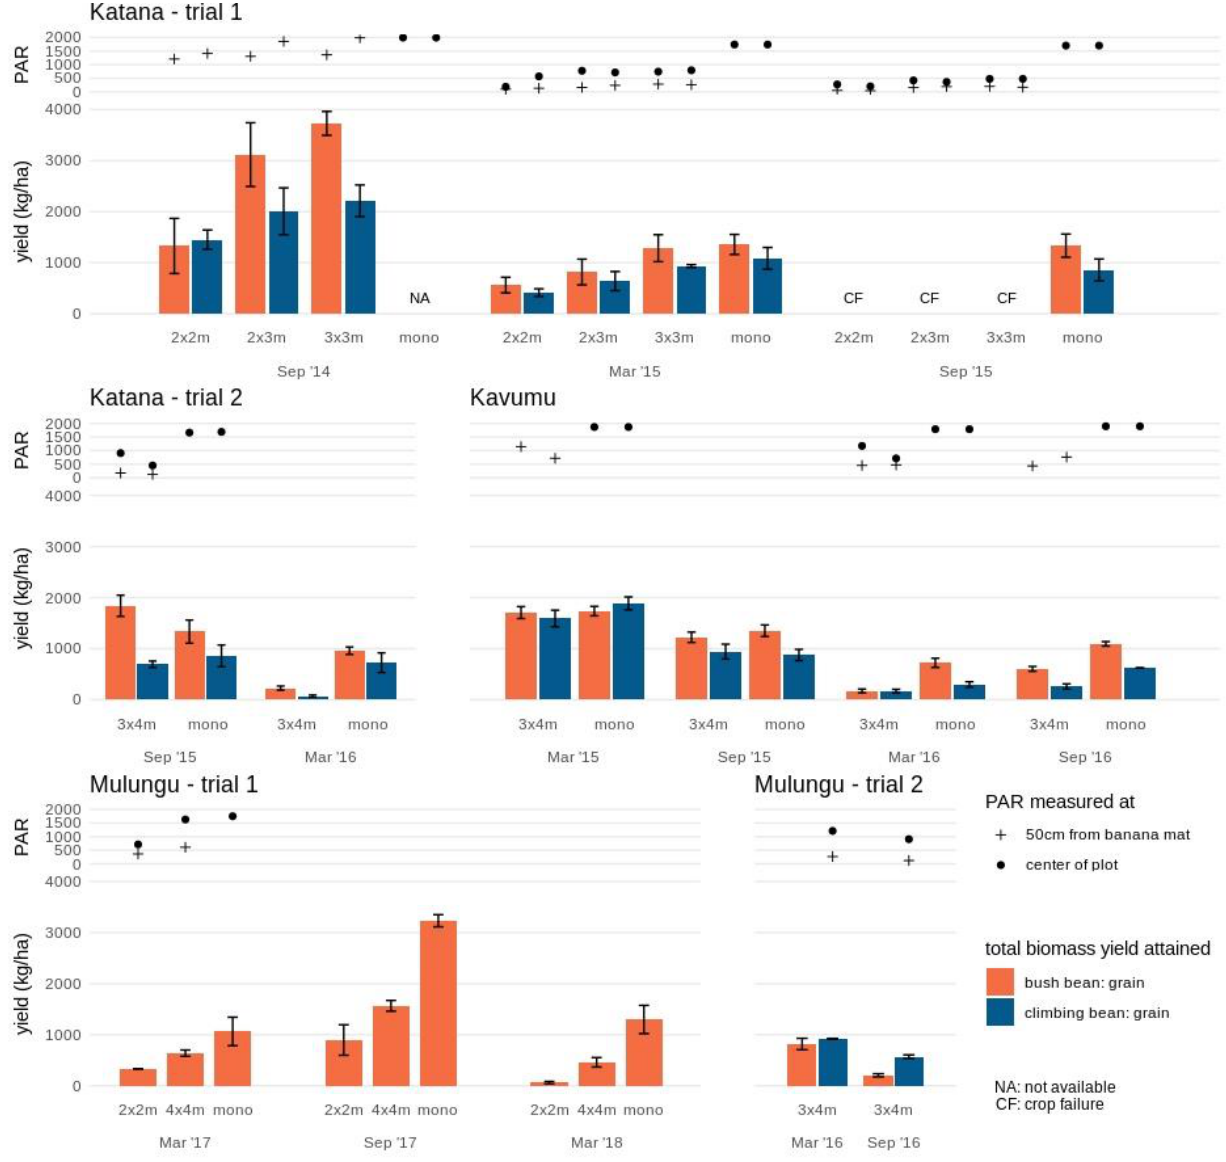
Figure 1. Crop performance of bush bean and climbing bean in various intercrop formations and monocrops at the study sites Katana, Kavumu and Mulungu. Grain yield is indicated separately for bush bean (orange) and climbing bean (blue) at each intercrop formation and cropping season. At Katana, the crop failure (CF) in September 2015 is indicated. The annual crop in monocrop formation is not assessed (NA) at Katana in September 2014 and not available in trial 2 at Mulungu. Photosynthetic active radiation (PAR) measured at the center of the plot (full circle) and 50 cm from the banana mat (cross) is indicated for each annual intercrop and monocrop. Note that during some stages of the experimental trial PAR measurements are not available due to temporary equipment defects.